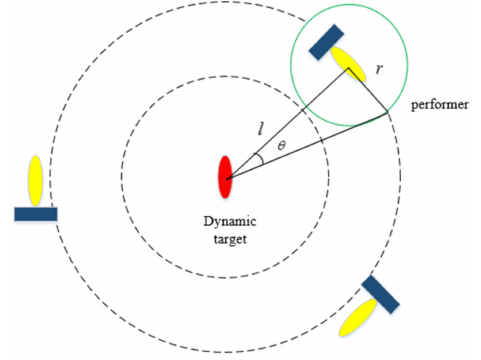
Figure 8. Reduction of encirclement.